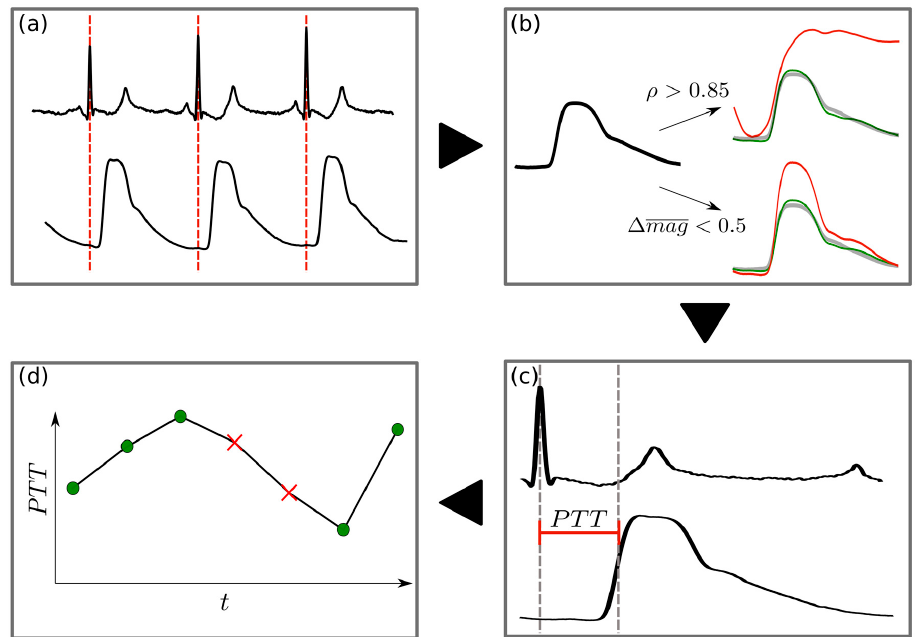
Figure 4. Flowchart of the PW detection pre-processing: ( a ) The R-peak in the ECG defines the PW onset. ( b ) The mean PW is identified as a robust template for physiologically plausible PWs in terms of morphology and magnitude. Each PW is then compared with a patient-specific template (green PW) for automatic deselection of non-optimal PWs (e.g., due to motion noise). A PW is rejected if either its Pearson correlation with the template is less than 0.85 or if the difference in normalized magnitude (i.e., area under the curve [AUC]), is greater than 0.5 (red PW). All remaining PWs are defined as valid. ( c ) For all valid PWs, PTT is calculated as the time from R-peak to the steepest rise in the PW. ( d ) For R-peaks where a PW is rejected, PTT values are inputted using a 4th order interpolation technique, WENO4. This interpolation is justified by the fact that 95% of all gaps in the PTT signal are less than 10 beats in length.